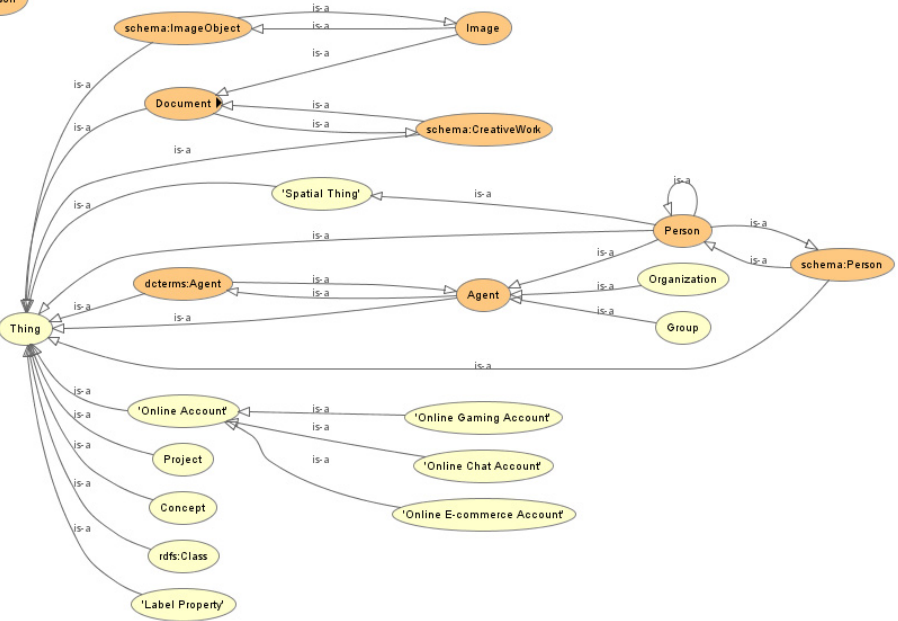
Fig. 7. General abstract classes of the FOAF